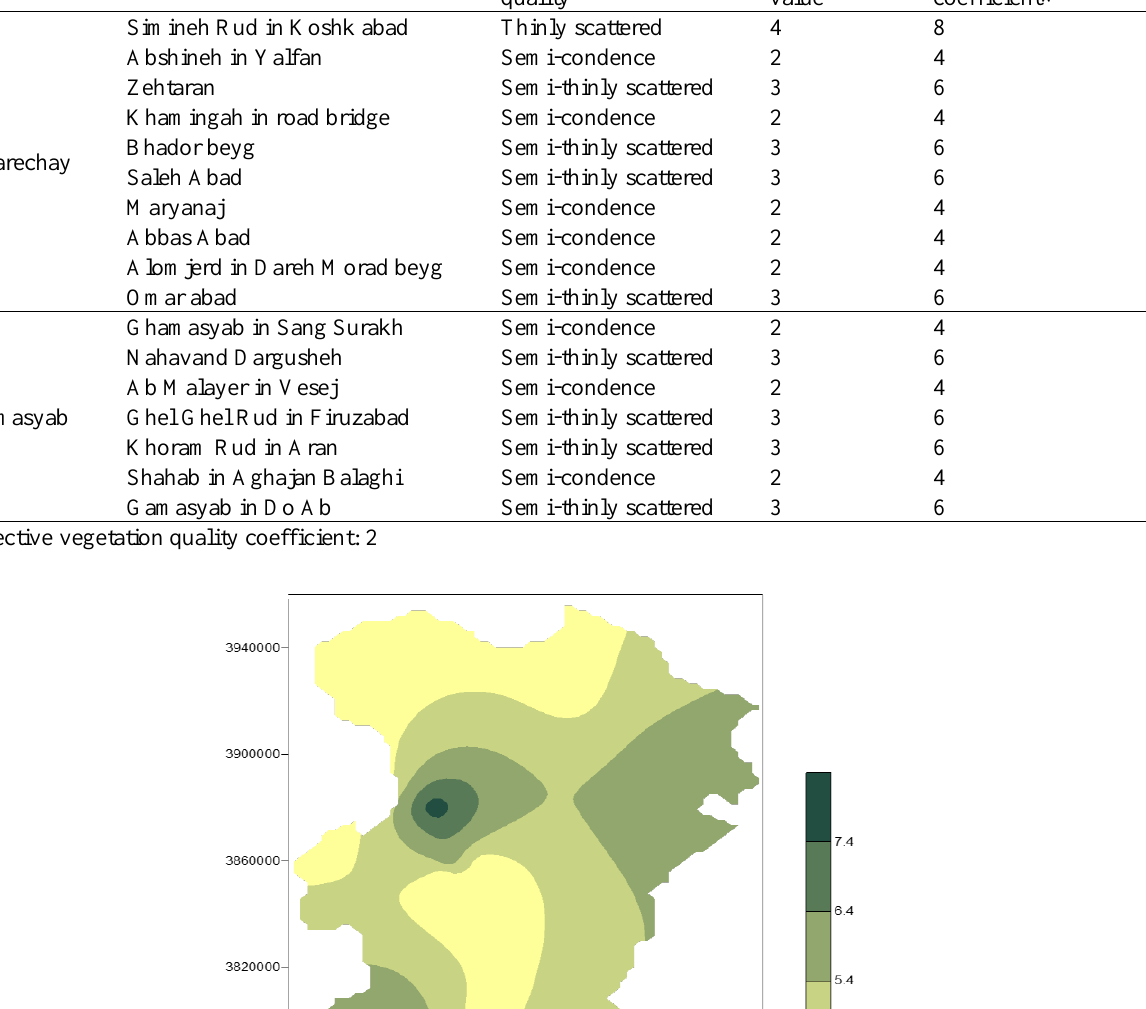
Table 6. Vegetation classification of Gamasyab and Gharechay sub-basins with quantitative coefficients Main basin